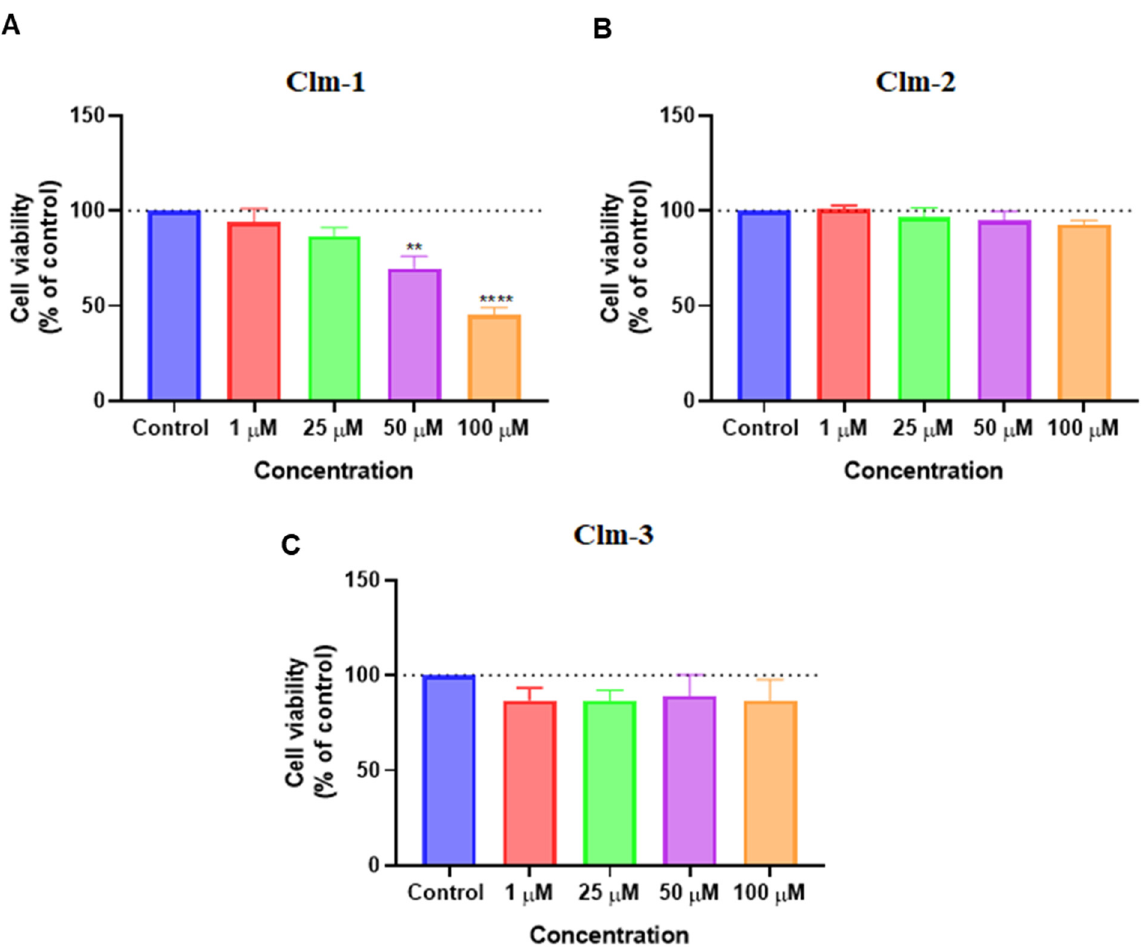
Figure 4. Cytotoxicity evaluation of compounds ( A ) Clm-1 , ( B ) Clm-2 , and ( C ) Clm-3 in PC-3 cells. PC-3 were treated with vehicle (methanol) and increasing concentrations (0–100 µM) of each compound for 48 h and cell viability was assessed by MTT assay. Data are given as the mean ± SEM ( n = 3), ** statistically significant vs. control (vehicle) at p < 0.01; **** statistically significant vs. control (vehicle) at p < 0.0001.